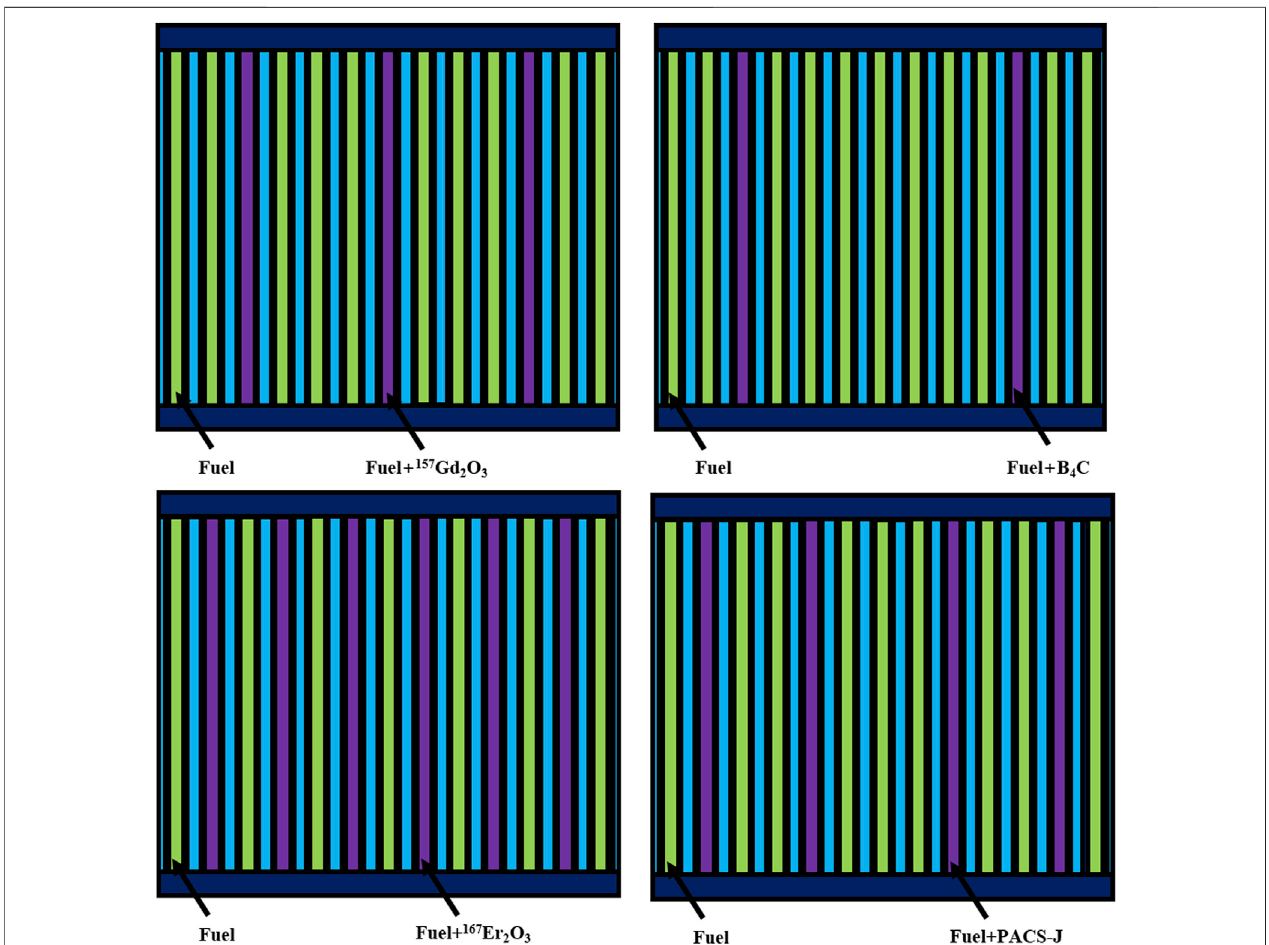
FIGURE 4 | Layout scheme of different burnable poison